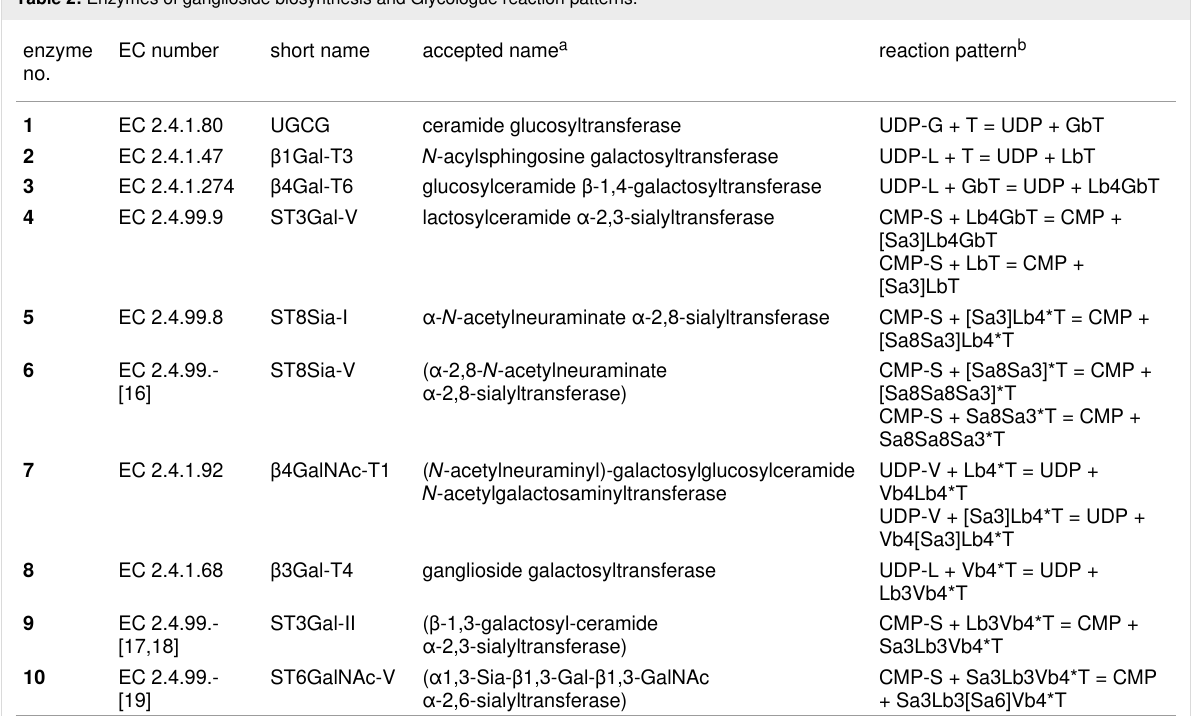
Table 2: Enzymes of ganglioside biosynthesis and Glycologue reaction patterns. enzyme